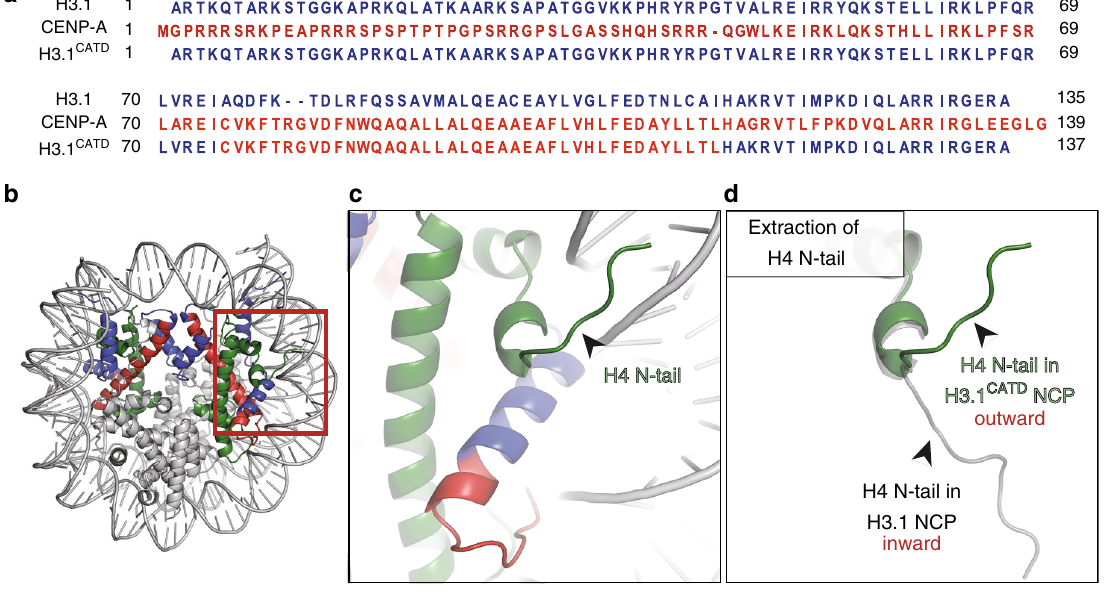
Fig. 1 Crystal structure of the nucleosome containing H3.1 CATD . a Alignment of the amino acid sequences of human histone H3.1, CENP-A, and H3.1 CATD . Amino acid residues derived from H3.1 and CENP-A are colored blue and red, respectively. b The crystal structure of the nucleosome containing H3.1 CATD . The H3.1 CATD regions derived from H3.1 and CENP-A are colored blue and red, respectively. H4 is colored green. H2A, H2B, and DNA are colored gray. c Close-up view of the H4 N-terminal tail in the H3.1 CATD nucleosome. The region enclosed by the red rectangle in b is enlarged. d Structural comparison of the H4 N-terminal tails between the H3.1 CATD nucleosome and the H3.1 nucleosome 76 (PDB ID: 5Y0C). The H4 N-terminal tails in the H3.1 CATD and H3.1 nucleosomes are colored green and gray,